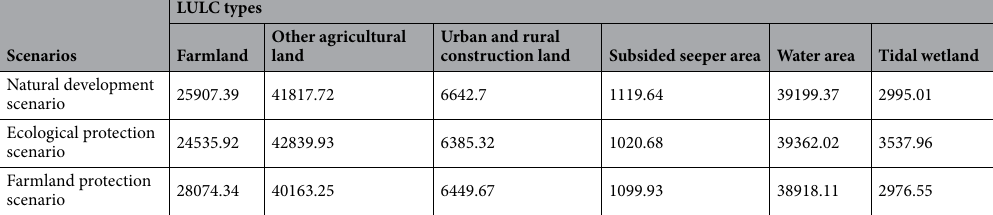
Table 2. Areas of LULC types in 2025 under different scenarios (ha).